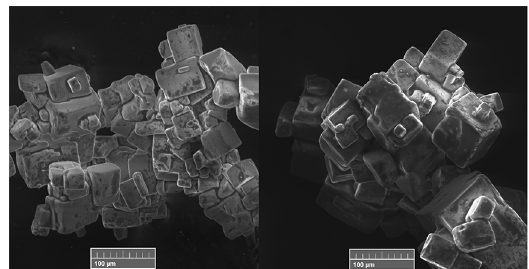
Figure 10. SEM sample with the discharge interaction (left) and control